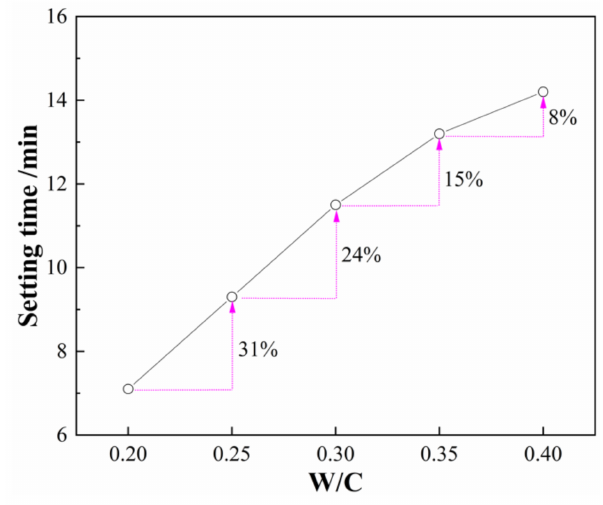
Figure 3. Influence of W/C ratios on the setting time of SLMKPC slurry.